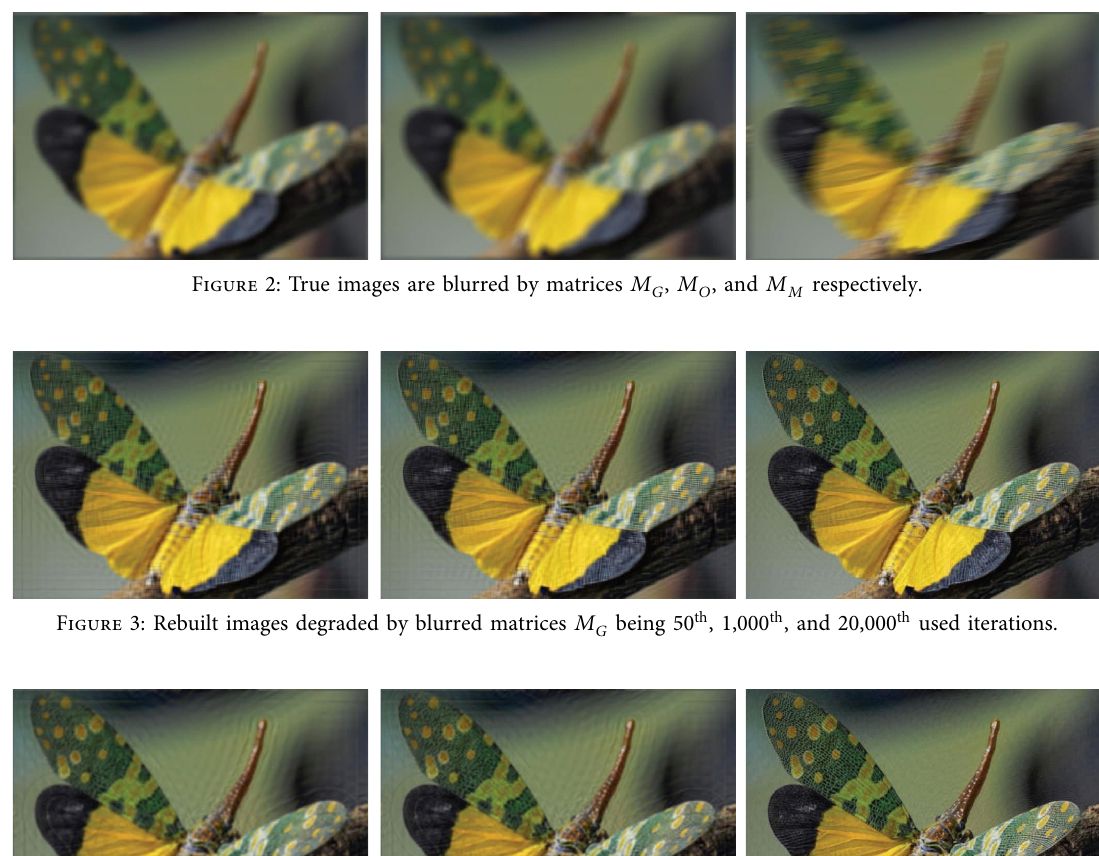
th , 1 , 000 th , and 20 , 000 th used iterations. O being 50